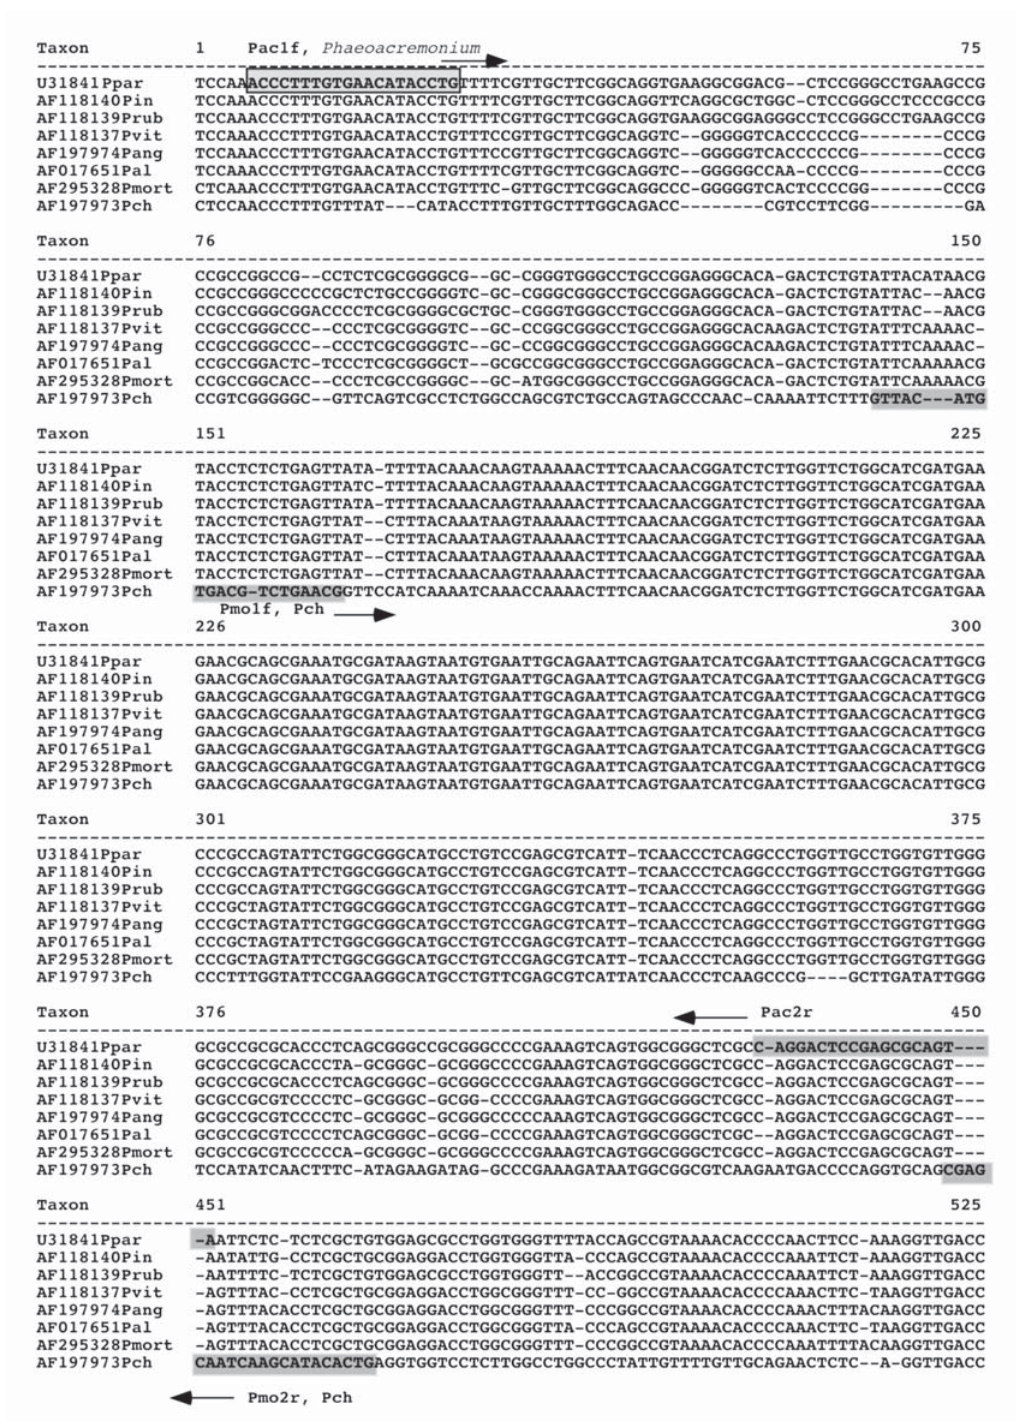
Fig. 1. Multiple alignment of ITS rDNA region. Primer pair locality is indicated by highlighted blocks. The sense of each primer is in accordance with the arrow reported above or below the